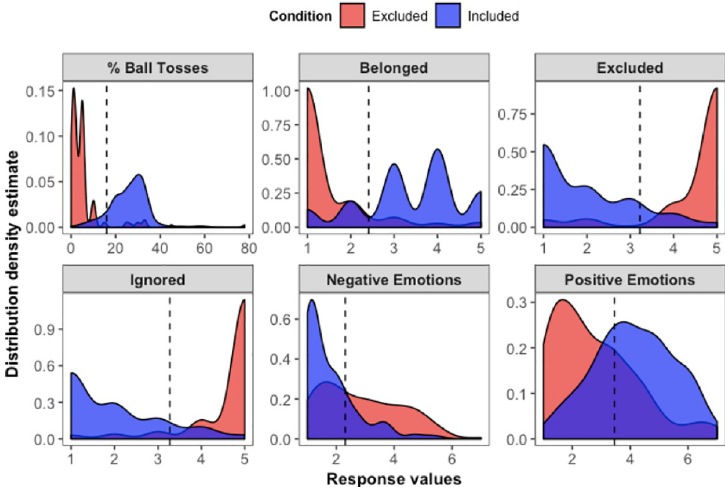
Fig 2. Distributions of manipulation check measures by Cyberball condition in Study 1. Dotted lines show the overall mean response value for each measure. All comparisons by Cyberball condition were significant at p < .001. For estimating the percentage of ball tosses, participants typed a number between 0 and 100. For the questions on feelings of belonging, being excluded, and being ignored, participants answered using 5-point scales (1 = Not at all ; 5 = Extremely ). For questions on positive and negative emotions, we created composite indices using the individual valenced items from the Affect-Adjective Scale (1 = Not at all ; 7 = Very much so